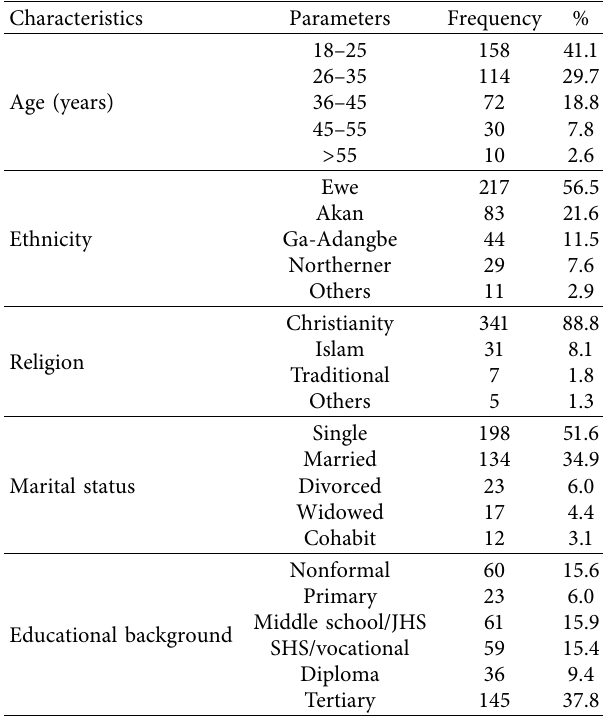
Table 1: Sociodemographic characteristics of respondents. Characteristics